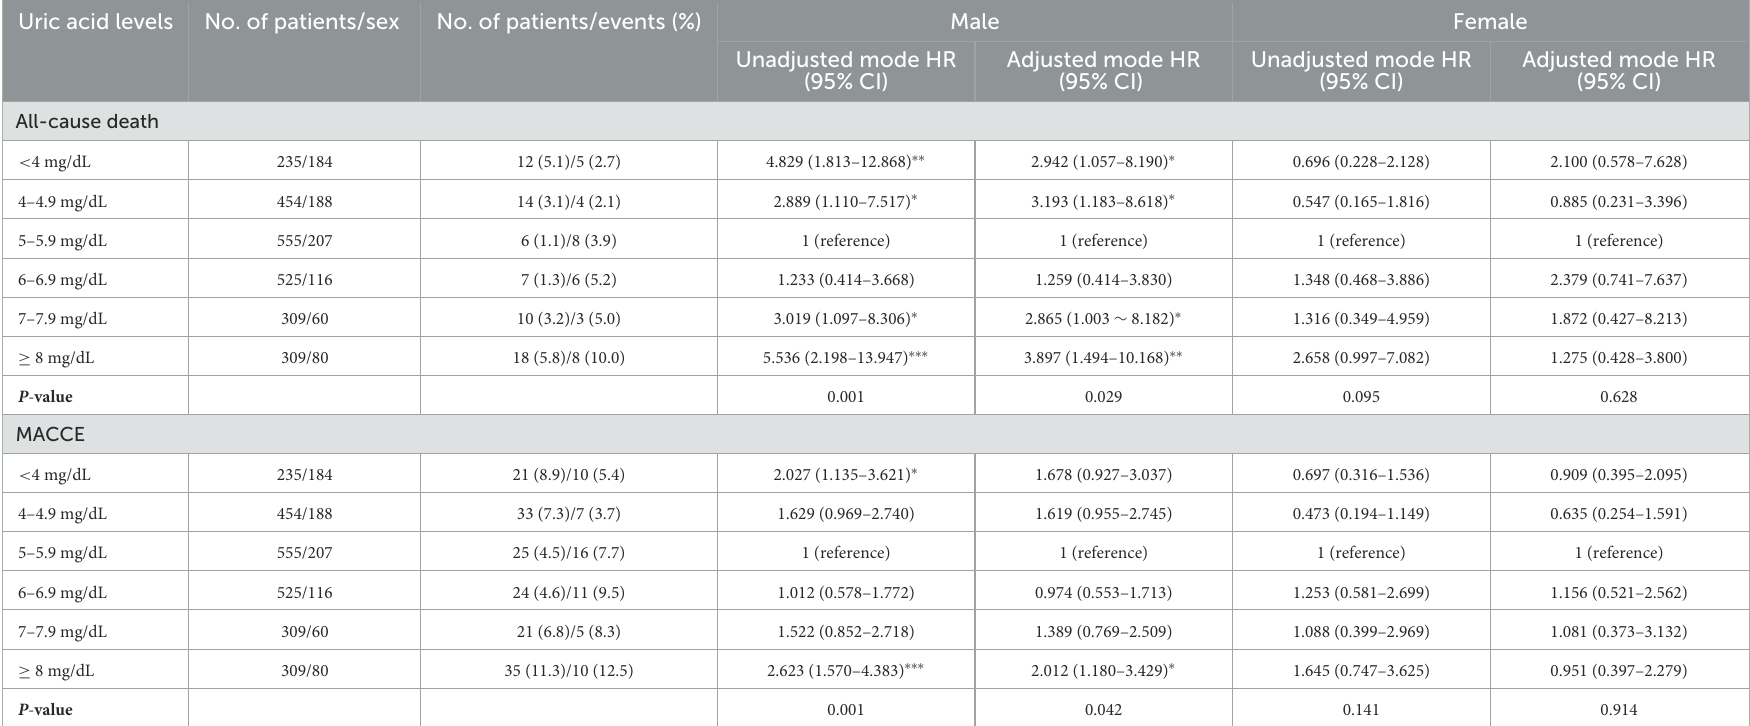
TABLE 2 Twelve-month all-cause death and MACCE by uric acid levels according to sex. Uric acid